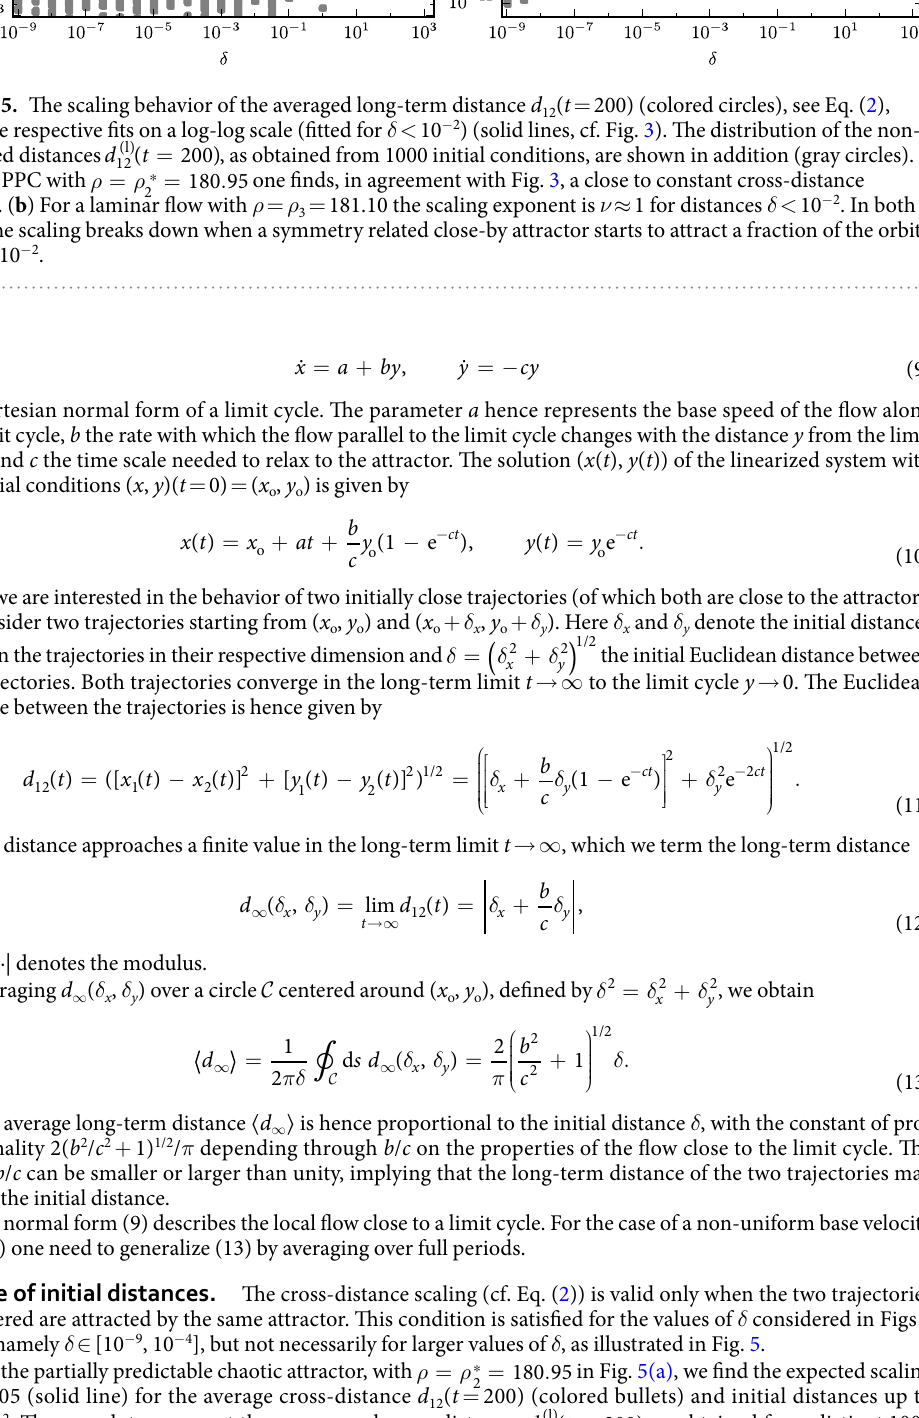
in Fig. 5(a), we find the expected scaling = 200) (colored bullets) and initial distances up to ν = 0.005 (solid line) for the average cross-distance d 12 ( t δ ≈ 10 − 2 . The gray dots represent the unaveraged cross-distances = d t ( 200) 12(l) , as obtained from distinct 1000 initial distances. For δ > 10 − 2 the two orbits start to end up in distinct attractors, as a second (symmetry related) PPC attractor exists close-by in phase space. After a crossover region δ ∈ [10 − 2 , 1] one observes a second scaling plateau for δ > 1.